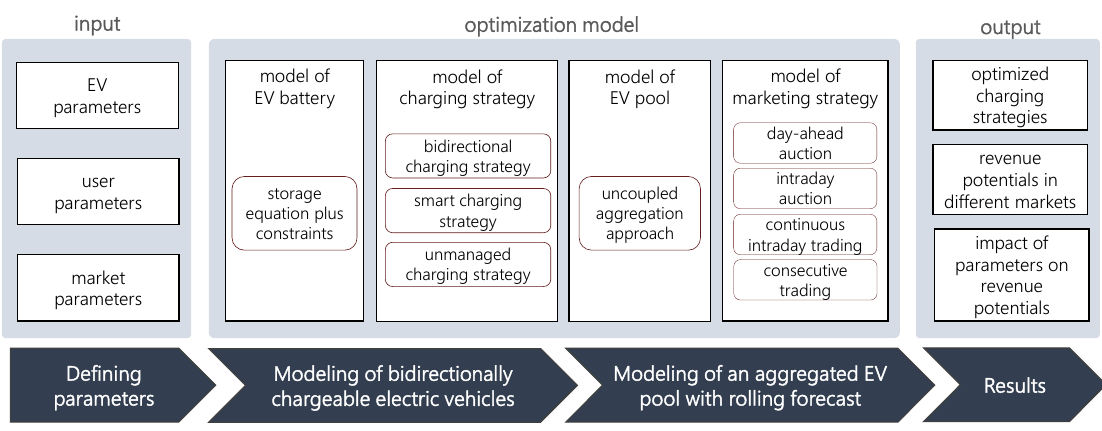
Figure 1. Schematic representation of the developed optimization model for Vehicle-to-Grid (V2G) use cases of bidirectional charging.